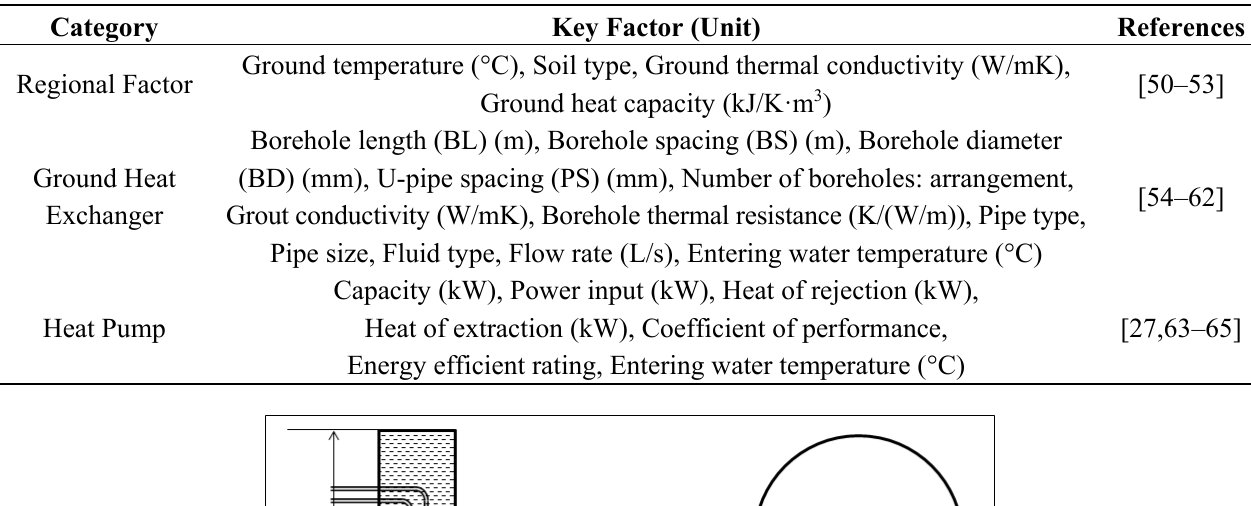
Table 1. Overview of key factor.